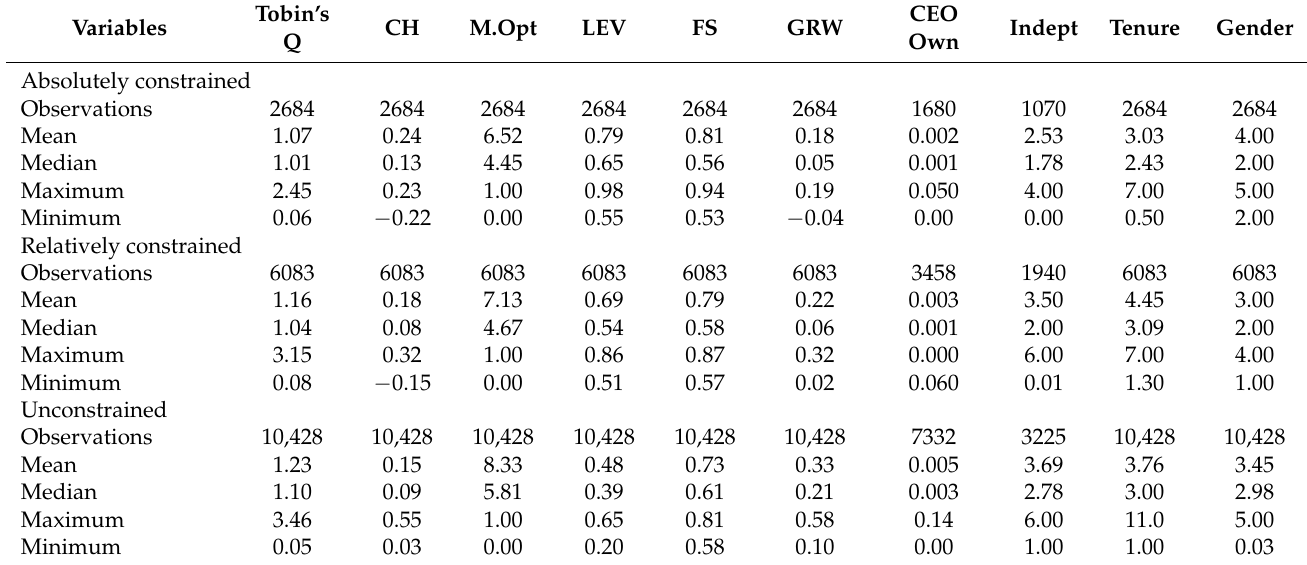
Table 5. Descriptive statistics of the absolutely constrained and unconstrained